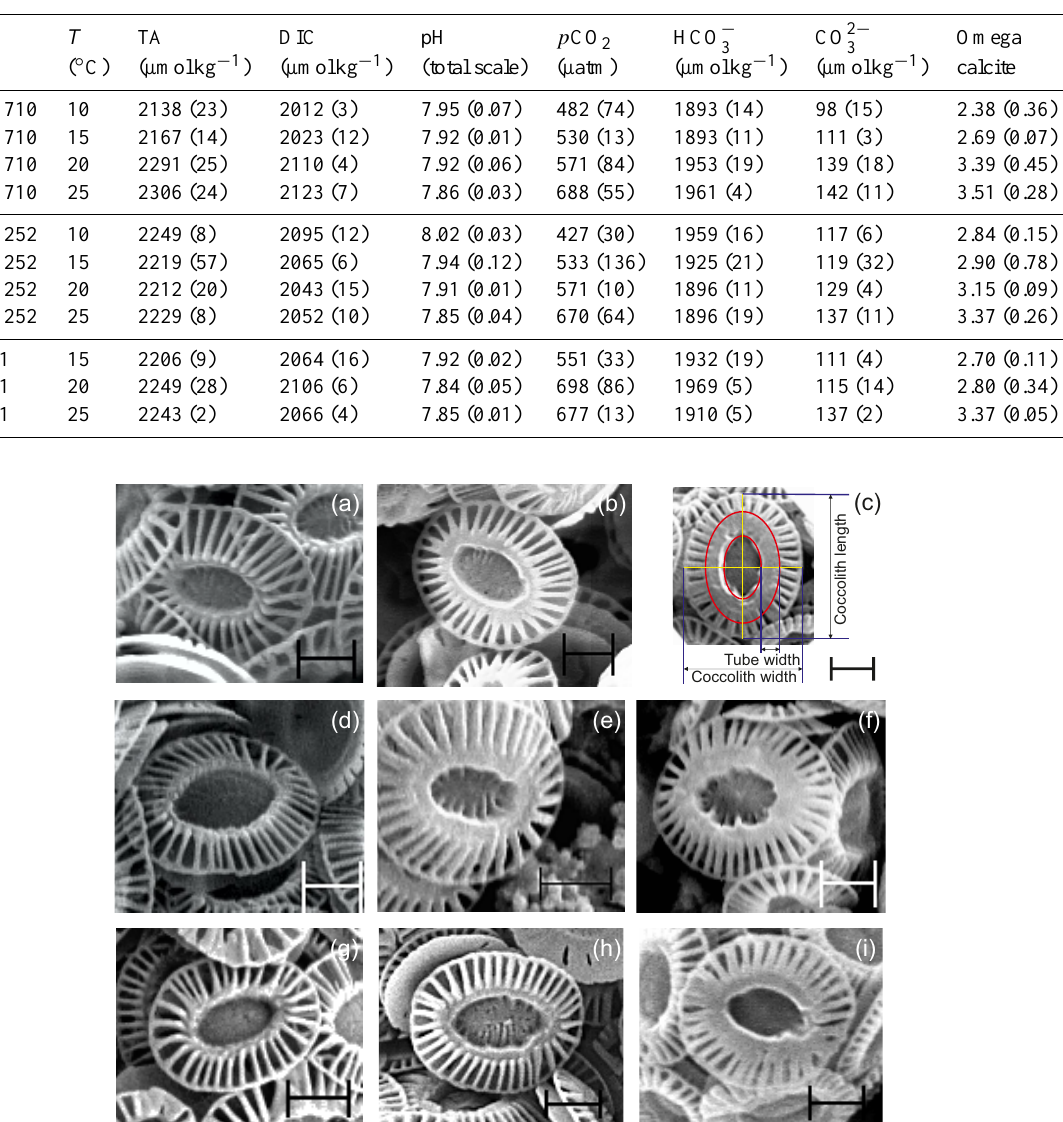
Table 2. The carbonate system final values. Standard deviation of the triplicates in parentheses.